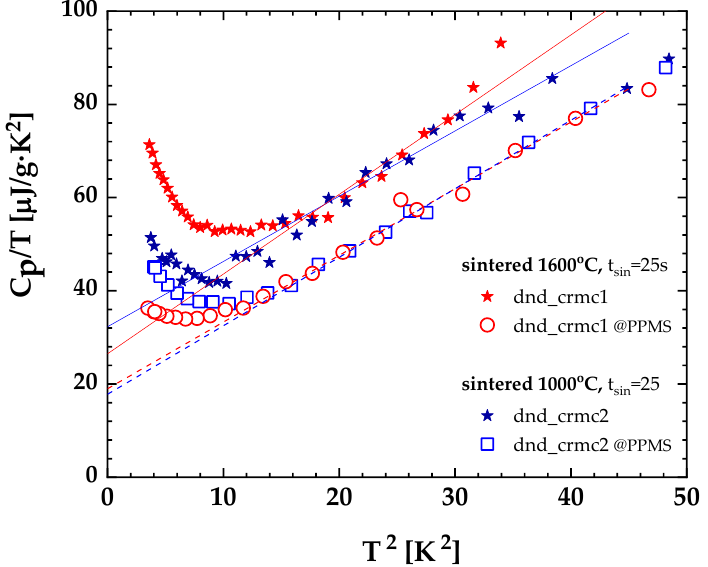
Figure 6. Low temperature specific heat in Cp/T representation as a function of square temperature for differently sintered detonated nanodiamond ceramics, measured at two complementary setups.